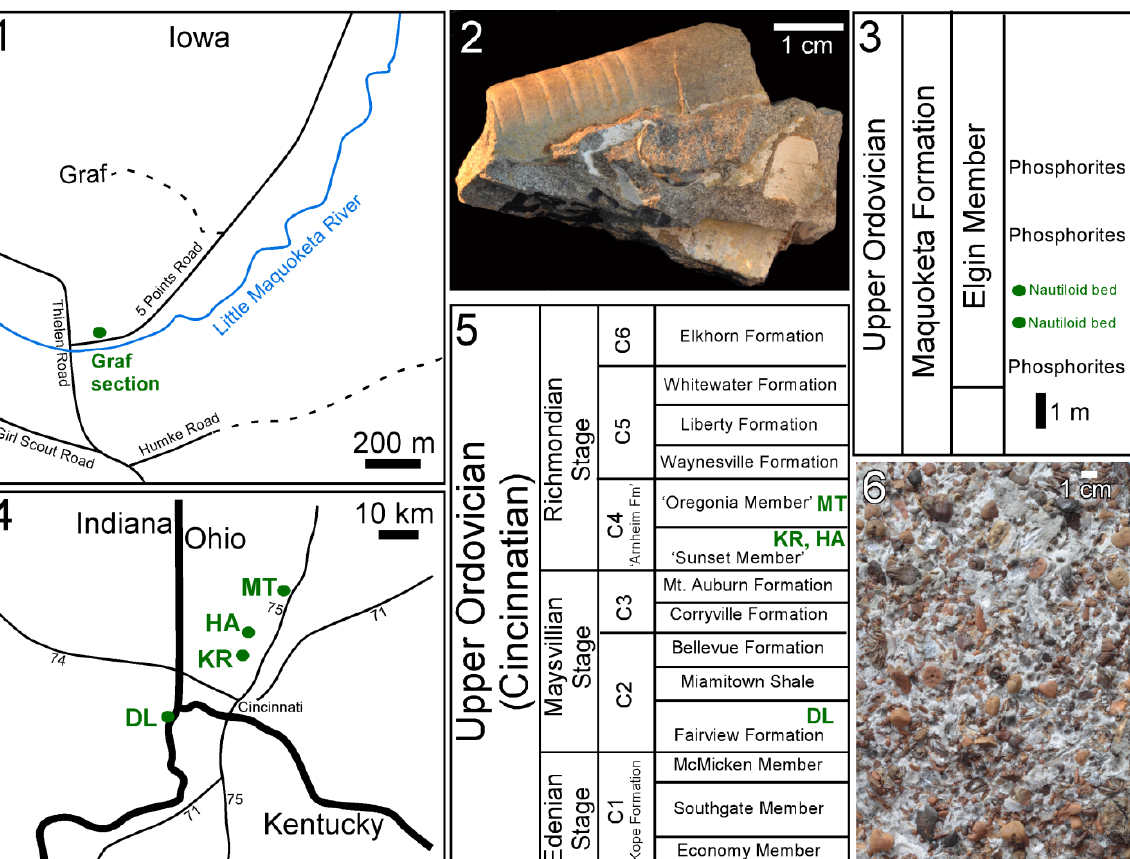
Figure 1. Localities, stratigraphic units, and fossils featured herein. ( 1 ) Location of Graf section; ( 2 ) Typical sample from the “Nautiloid beds” of the Maquoketa Formation at Graf, showing remains of multiple cephalopods; ( 3 ) Position of “Nautiloid beds” at Graf section from which Isorthoceras was recovered; ( 4 ) Locations where Cyclora beds of phosphatic internal moulds of molluscs were recovered; ( 5 ) Stratigraphic distribution of the Cyclora beds that yielded fossils illustrated herein; ( 6 ) Etched surface of Cyclora bed from Kemper Road, Cincinnati, OH. Key: DL = Dearborn/Lawrenceburg, IN; HA = Hamilton, OH; KR = Kemper Road, OH; MT = Middletown, OH. Sequence stratigraphic cycles (C1–C6) shown in ( 5 ) are based on Holland